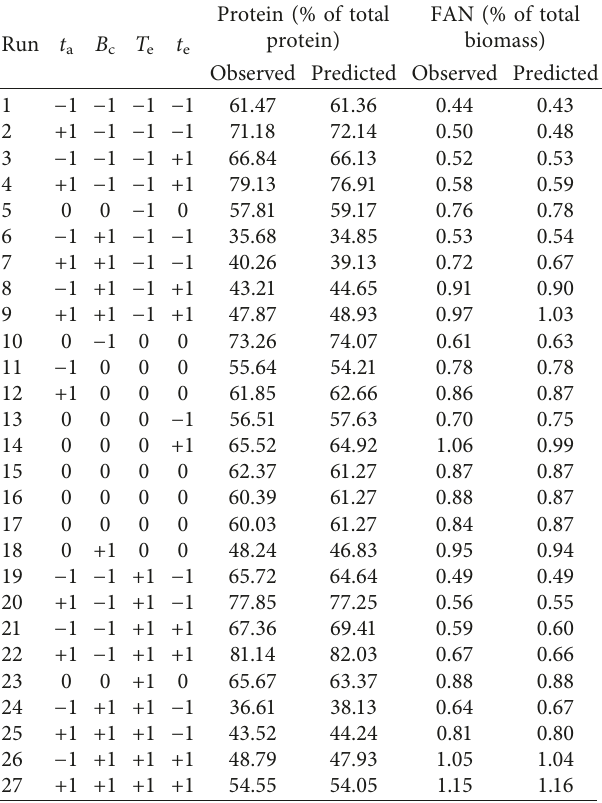
Table 2: Experimental design and results of the face-centered